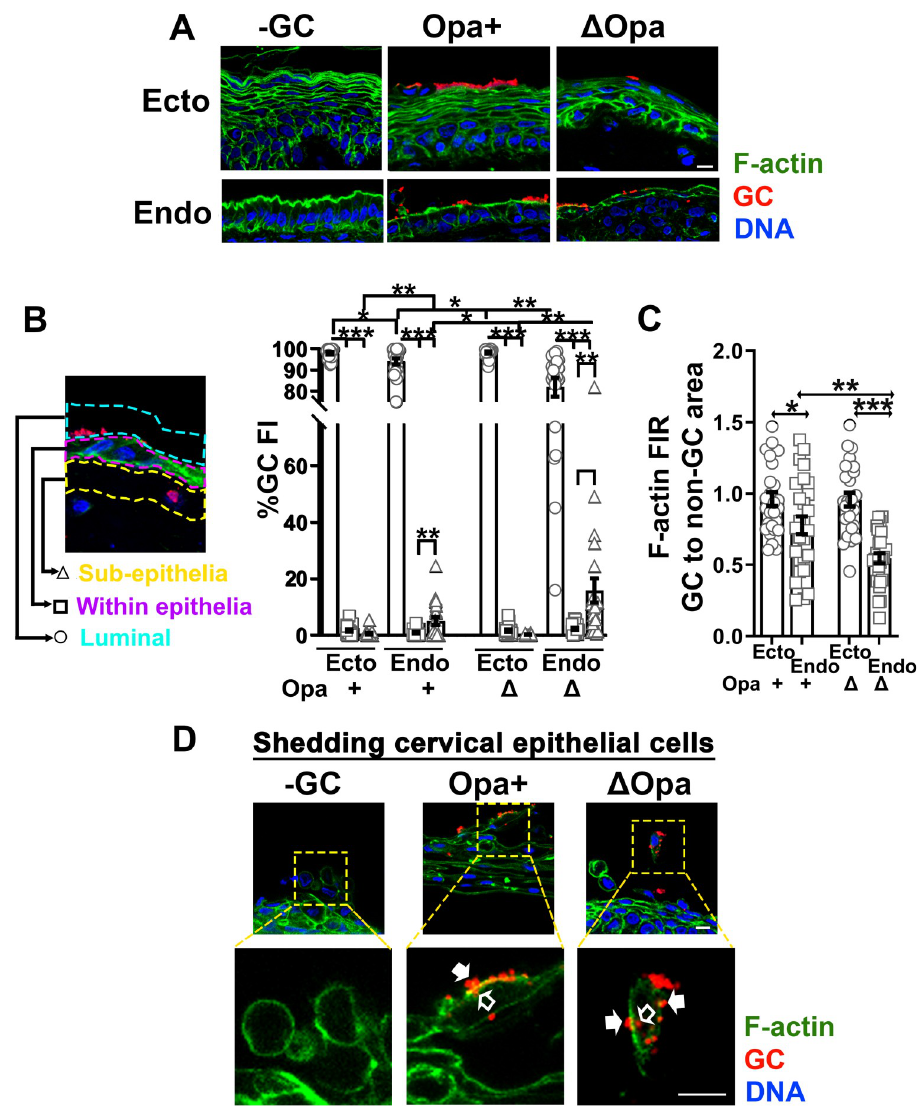
Fig 6. The level of intraepithelial GC is much lower than those on the luminal surface and/or in the subepithelia of the ecto- and endocervix. Human cervical tissue explants were incubated with Pil+Opa+ and Pil+ Δ Opa (MOI~10) for 24 h, with unassociated GC washed off at 6 and 12 h. Tissue explants were fixed, stained for F-actin, GC and DNA, and analyzed using CFM. (A) Shown are representative images of the ecto and endocervix. Scale bar, 10 μ m. (B) The distribution of GC in cervical tissues was quantified by the percentage of GC fluorescent intensity (% GC FI) detected at the luminal surface (blue dash lines), within the epithelium (magenta dash lines), and at the subepithelium (yellow dash lines), relatively to the total GC FI in the entire area. Data points represent individual randomly acquired images. (C) The redistribution of F-actin was quantified by the FIR ( ± SEM) of phalloidin staining underneath individual GC microcolonies relative to the adjacent no GC luminal area. Data points represent individual GC microcolonies. (D) Shown are representative images of shedding cervical epithelial cells stained for GC, F-actin, and DNA. Open arrows, intracellular GC. Filled arrows, surface GC microcolonies with F-actin accumulation. Scale bar, 10 μ m. n = 3 three cervixes. � p < 0.05; �� p < 0.01; ��� p <